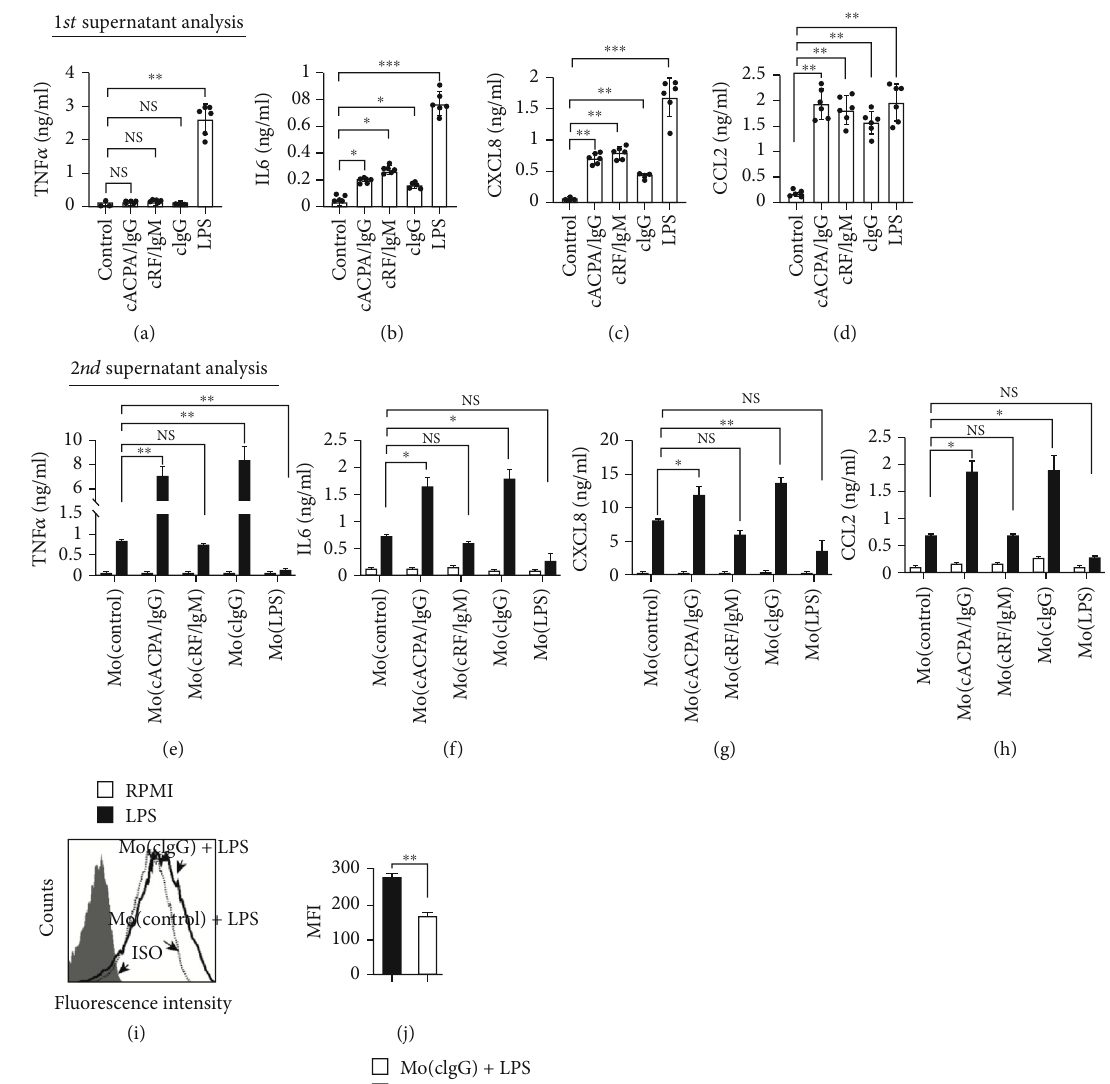
Figure 2: Enhanced LPS response by ACPA IgG-primed monocytes. (a – d) ELISA quanti fi cation of TNF α , IL6, CXCL8, and CCL2 in the supernatant during monocyte priming. After priming, the Mo(cACPA/IgG), Mo(cRF/IgM), Mo(cIgG), Mo(control), and Mo(LPS) were treated with LPS (10 ng/ml); monocytes treated in RPMI 1640 medium were used as the control (RPMI). (e – h) ELISA quanti fi cation of TNF α , IL6, CXCL8, and CCL2. Each dot represents one donor ( n = 6 ). (i) The Mo(cIgG) and Mo(control) were stimulated with LPS (10 ng/ml) for 2h, followed by intracellular staining of TNF α . (j) Cells stained with isotype control Abs ( fi lled histogram) were used as negative controls. The MFI of TNF α was compared. Data ( mean ± SEM ) are from three independent experiments. NS: no statistical signi fi cance; ∗ P < 0 : 05 , ∗∗ P < 0 : 01 , and ∗∗∗ P < 0 : 001 . The Kruskal – Wallis test was performed, followed by post hoc testing by Dunn ’ s multiple comparison test, for comparing > 2 groups. The Mann – Whitney U test was used for comparing two